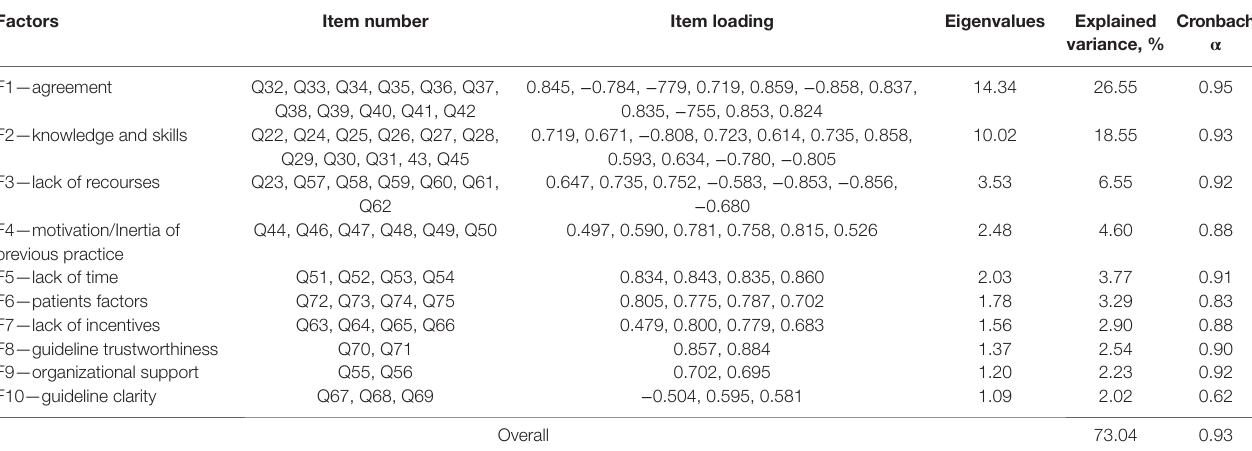
TaBle 1 | Exploratory factor analysis of overall questionnaire ( n =